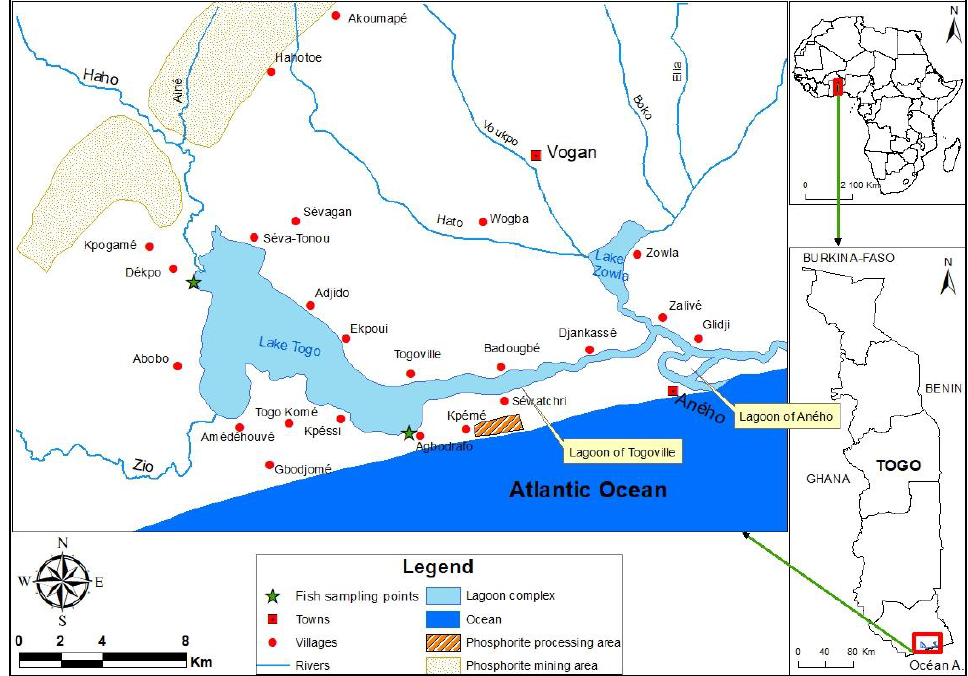
Figure 1. Location map showing sampling sites.